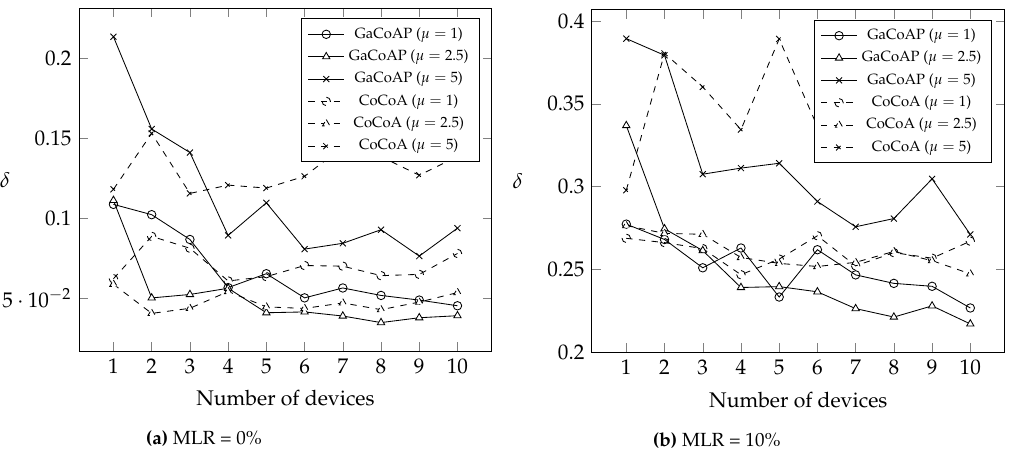
Figure 8. The average number δ of retransmission under different numbers of devices.